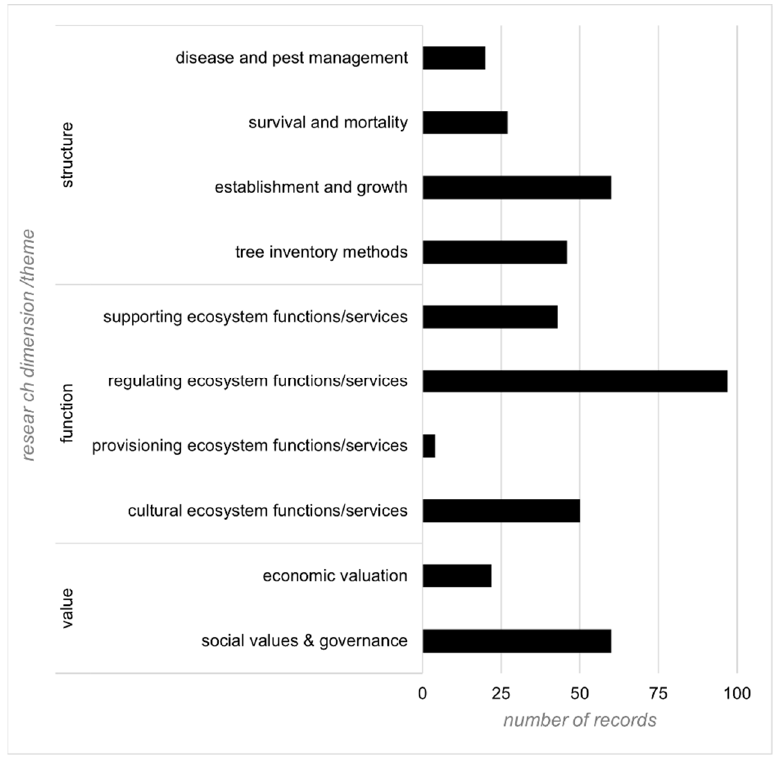
Figure 3. Distribution of records by research dimension and theme/topic.